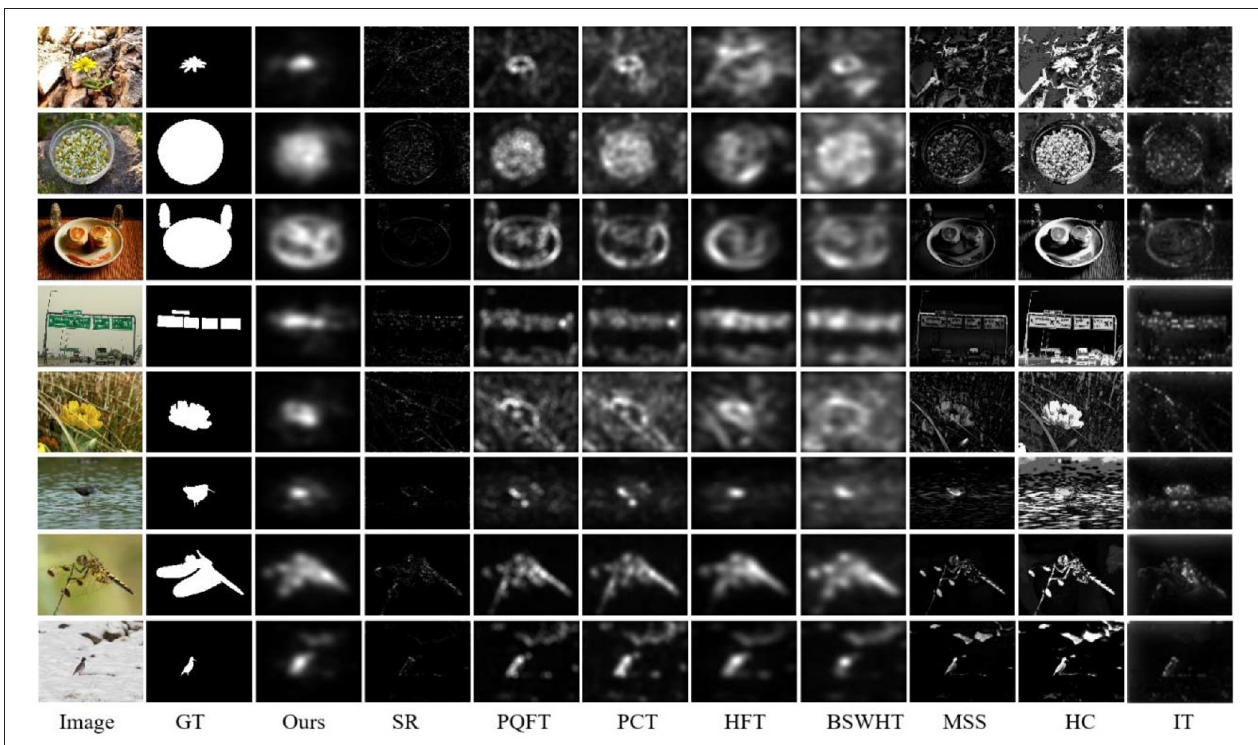
FIGURE 4 | Visual comparison of all saliency approaches on ECSSD